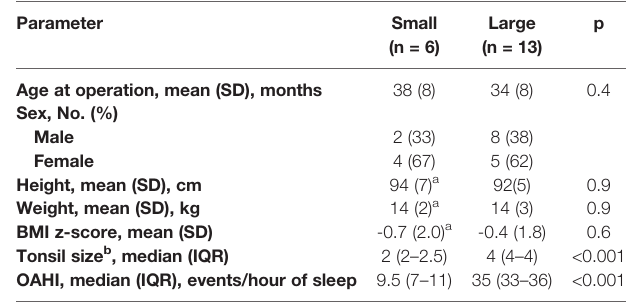
TABLE 1 | Baseline characteristics of the patient